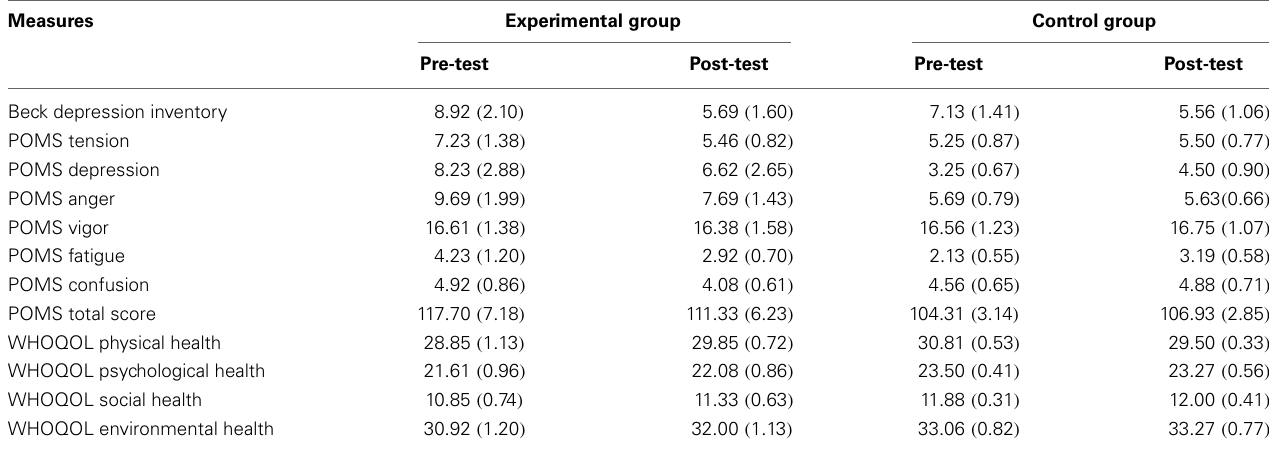
Table 5 | Mean ( SE ) for the mood and quality of life